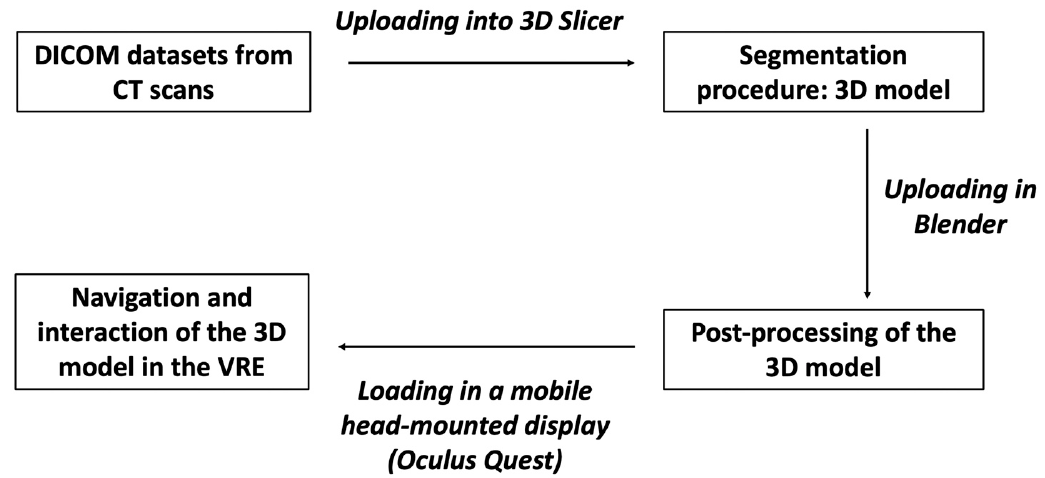
Figure 1. The fi gure shows the di ff erent steps to obtain a 3D model from CT scans to be visualized in the HDMI.